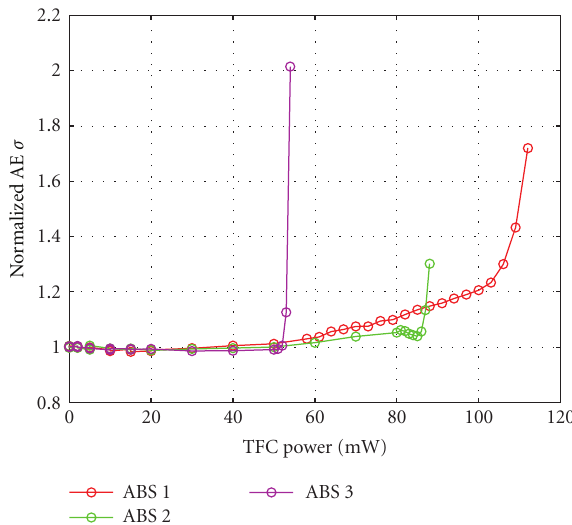
Figure 1: Touchdown plots for the three di ff erent ABS designs.